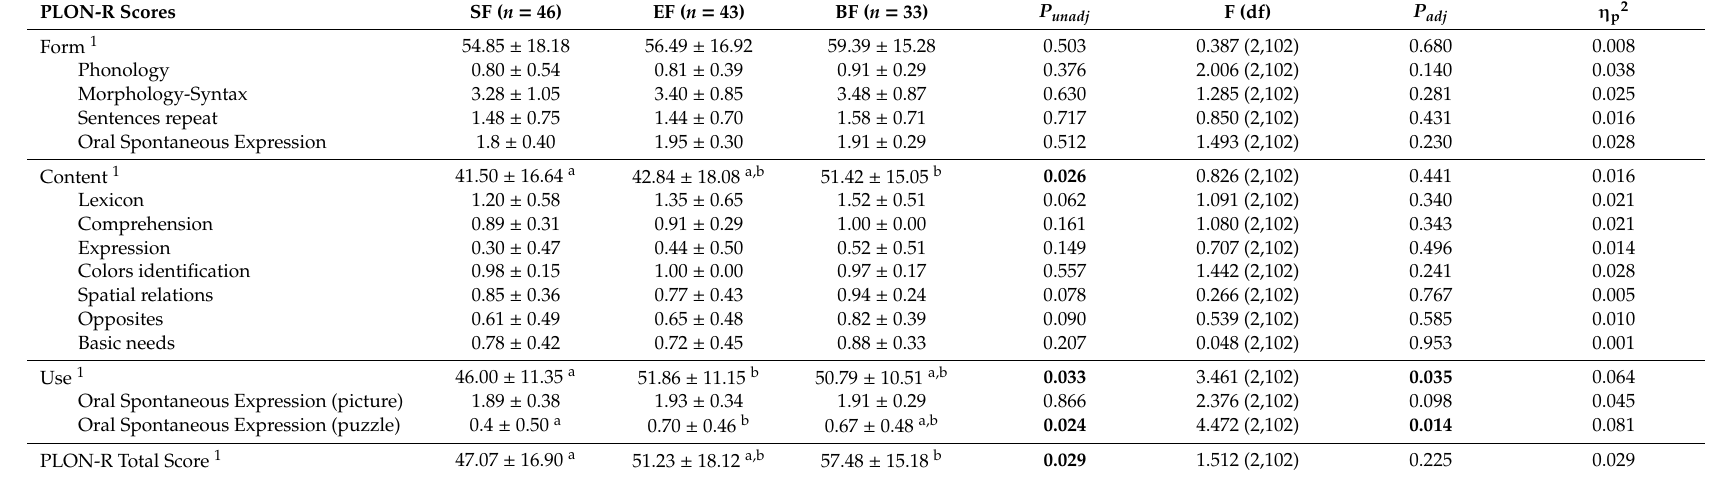
Table 2. E ff ects of infant formulas on language development at four years